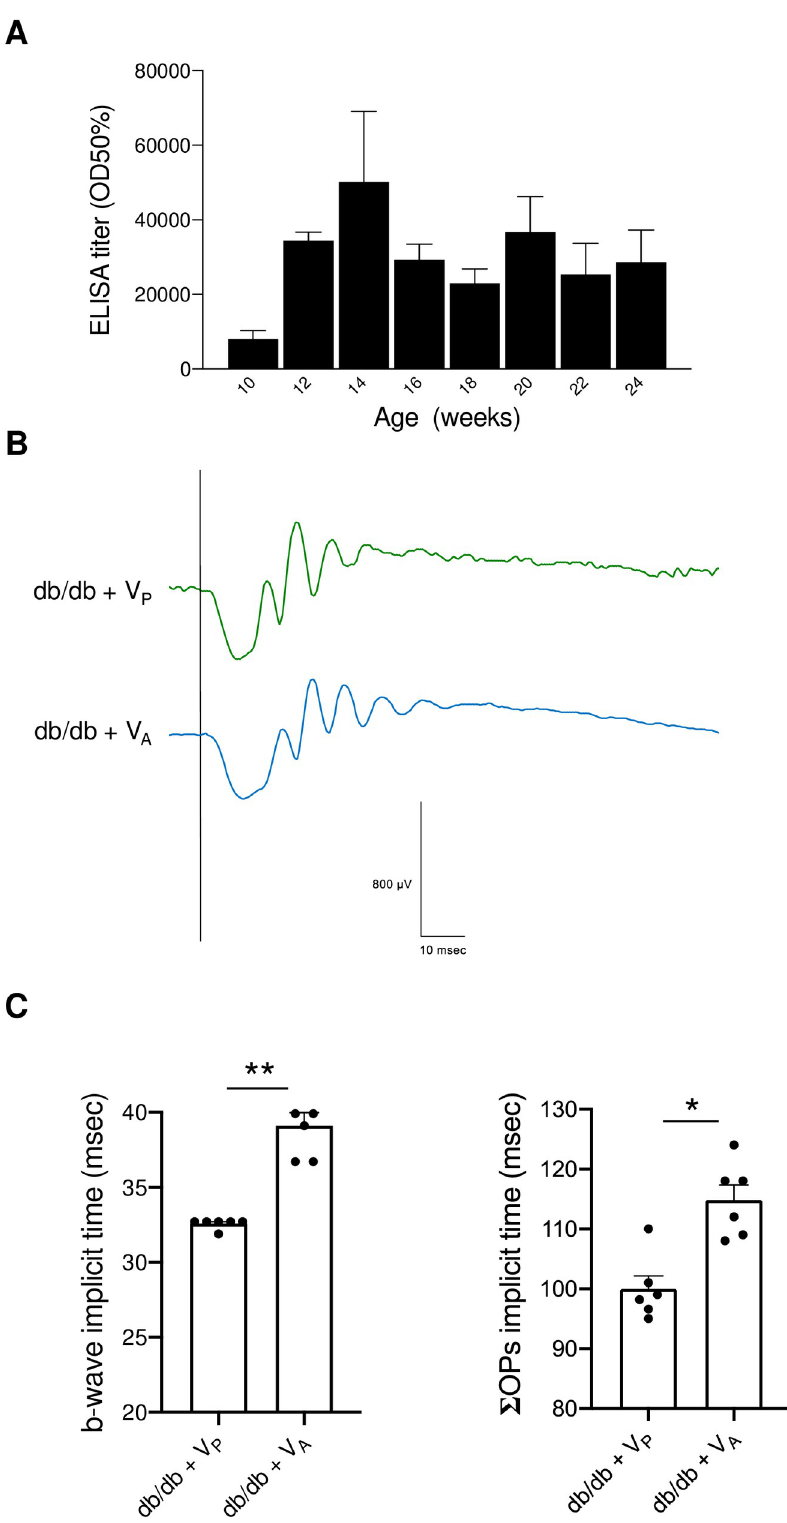
Fig 9. Comparison of neuroprotection by angiotensin II peptide vaccine (V A ) and prorenin peptide vaccine (V P ) in the retina of db/db mice. (A) Antibody titer (mean ± SE) in db/db + V A mice. (B) Representative electroretinogram traces in db/db + V P (green line) and db/db + V A (blue line). (C) Implicit time of b-wave and total sum of the